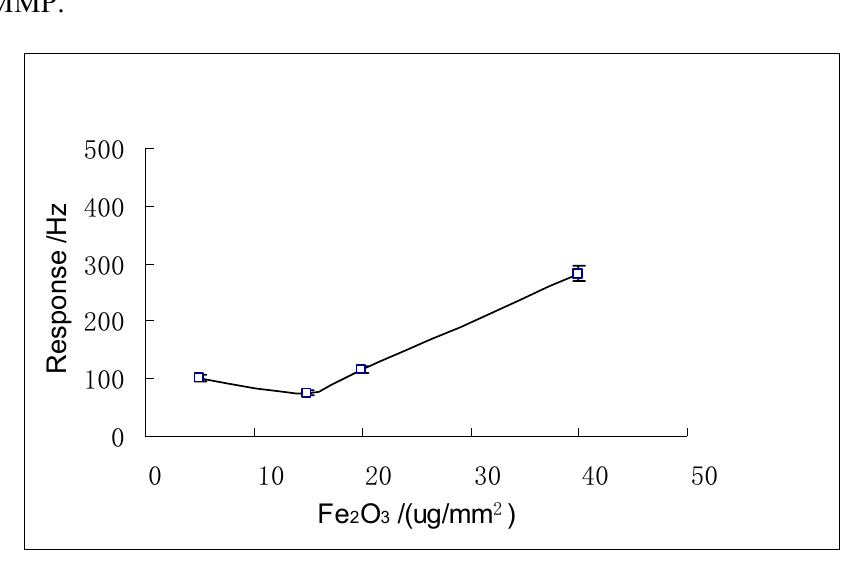
Figure 5. The response curve of various sensing film thicknesses of SENSOR No.1 to 4 ppm DMMP.